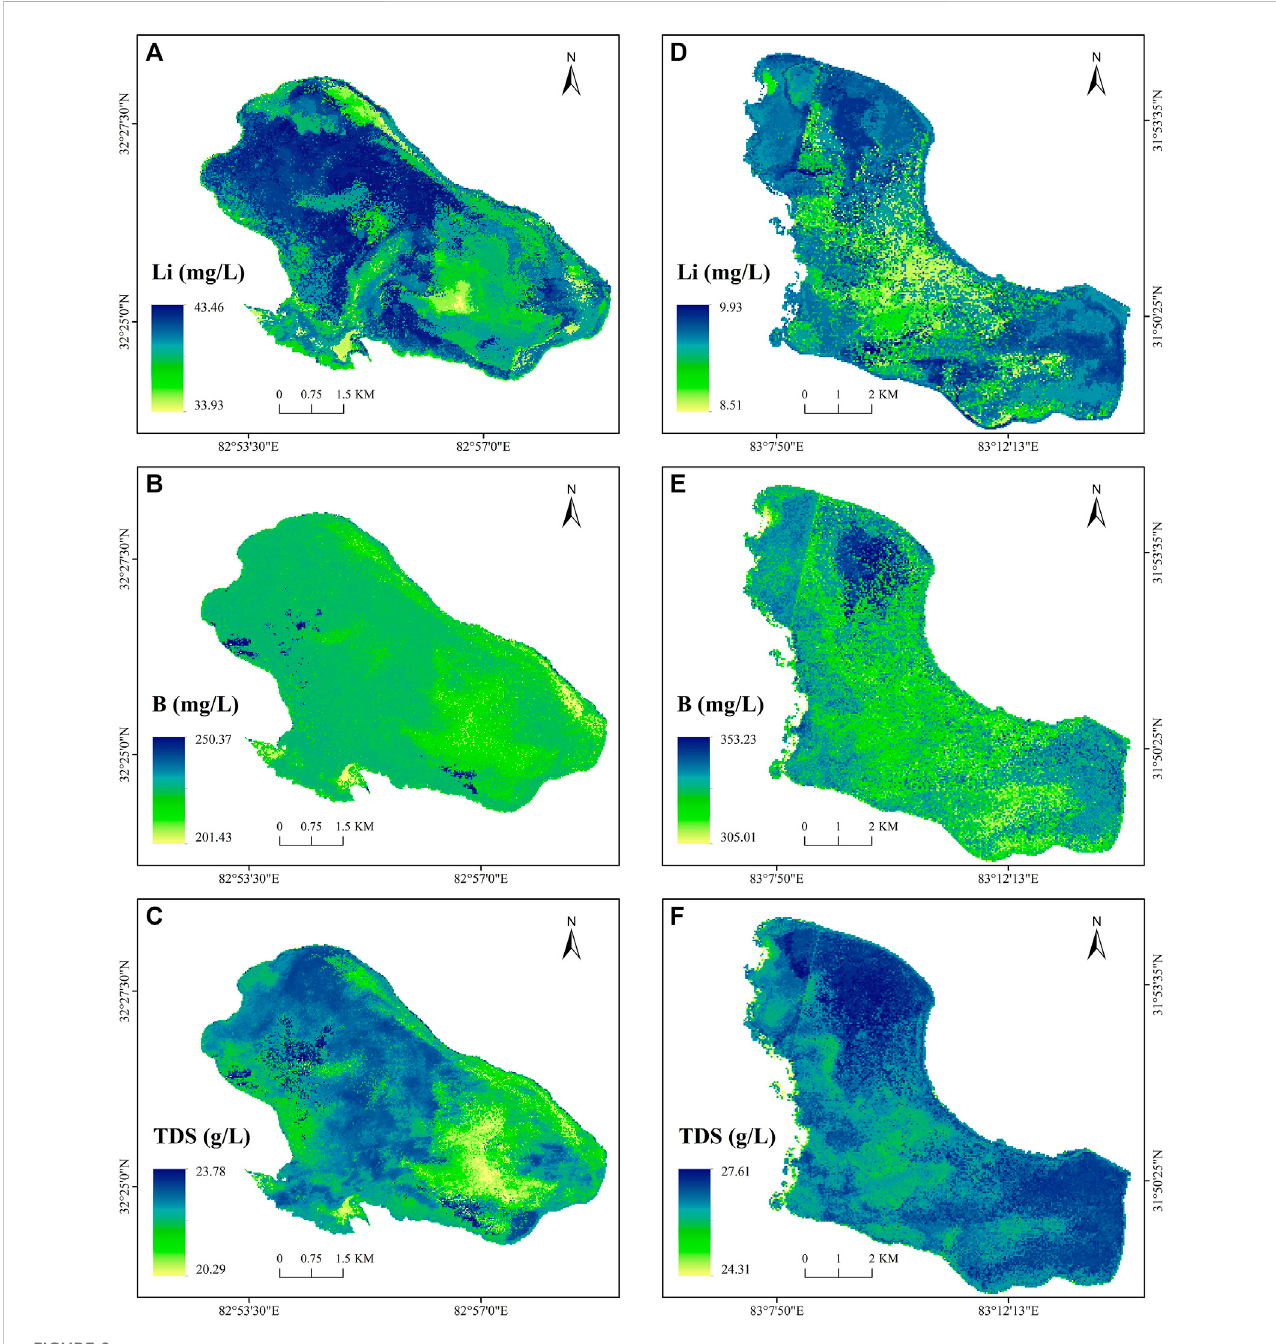
FIGURE 9 Spatial distribution of mineral content in Bieruoze Co and Guopu Co by using GA-RF model. (A) , (B) , (C) are the distribution maps of the Li, B, and TDS contents of Bieruoze Co. (D) , (E) , (F) are the distribution maps of the Li, B, and TDS contents of Guopu Co.